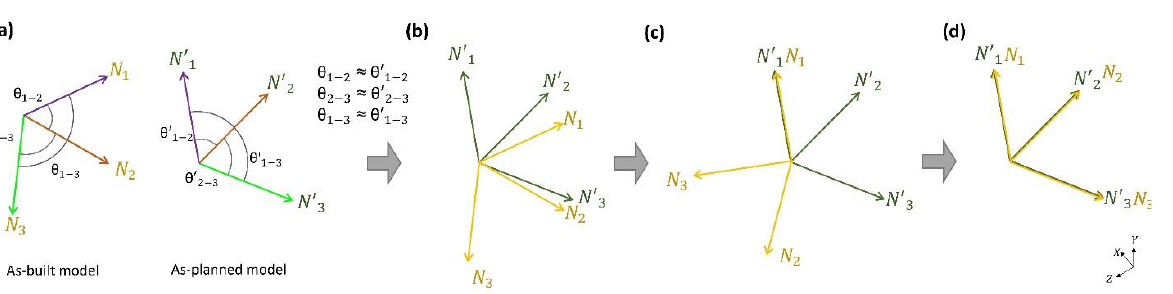
Figure 5. Visualization of ( a ) possible combinations with directions from the clustered plane segments having the same relative angles in the as-built and as-planned model, ( b ) normal vectors from as-built (yellow) and as-planned (green) models before rotation ( c ), the alignment of a pair of corresponding normal vectors after the first rotation, and ( d ) the aligned normal vectors of both models after the final rotation.